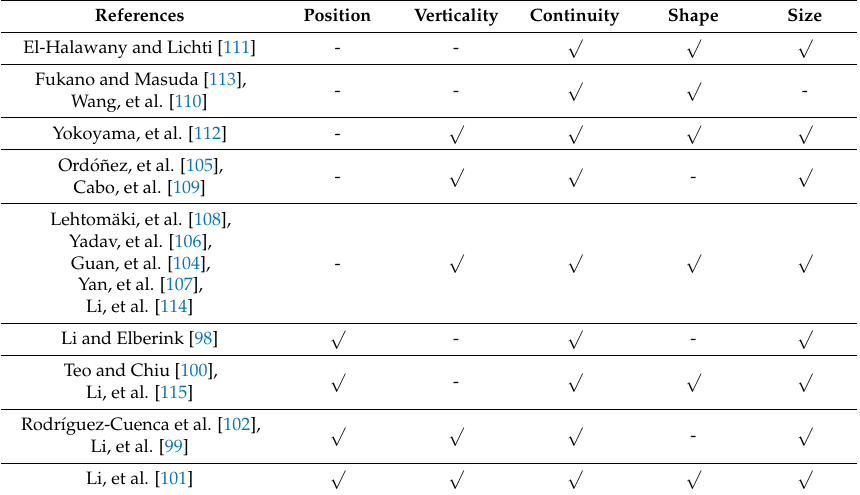
Table 6. Summary of characteristics used to define a pole-like object in the existing methods.